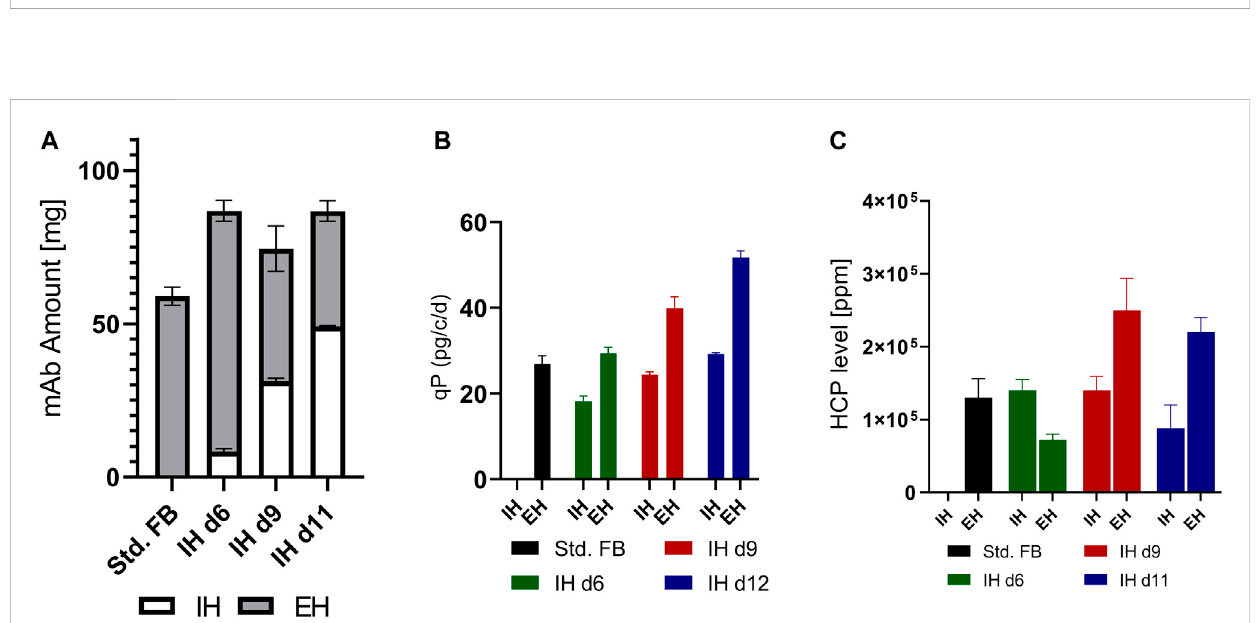
FIGURE 2 Cultivation results over time for a standard fed-batch (std. FB) cultivation with and without a complete media exchange at different time points. (A) , (B) ,and (C) Viablecellcount(VCC) andviability(Via.)over time for amedia exchange on day6(IH d6; n =3),day9(IH d9; n =3), andday11(IH d11; n = 2), respectively,comparedtothestd.FB( n =3)cultivation;therespectivetimepointsofmediaexchangeareindicatedbythedottedline. (D) IVCCvaluesfor all cultures over the total cultivation period. (E) Cell diameter over time for each cultivation.